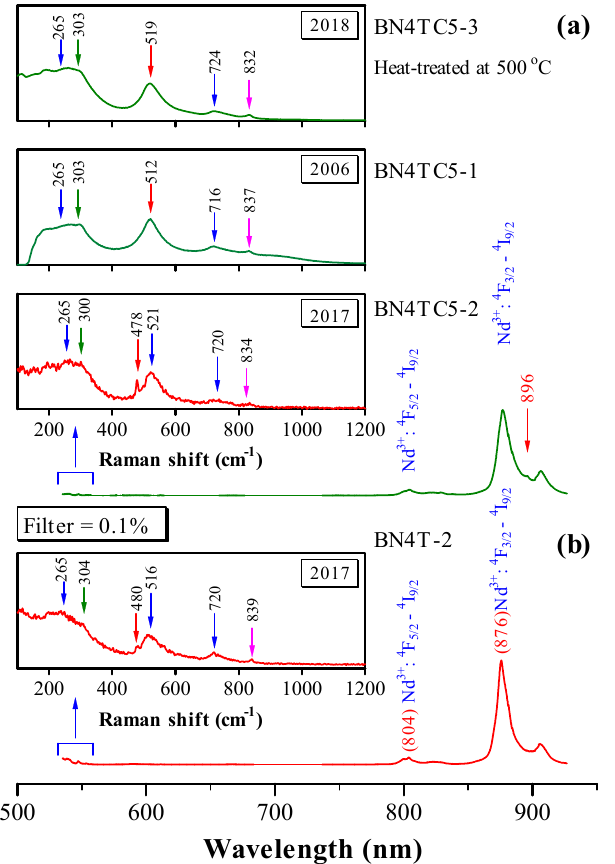
Figure 6. Raman scattering spectra and photoluminescence of ( a ) BN4TC5 and ( b ) BN4T, shown in wavelength. Excitation: 532 nm laser line. The insets show enlarged pure Raman signals at around 550 nm, shown in Raman shift.